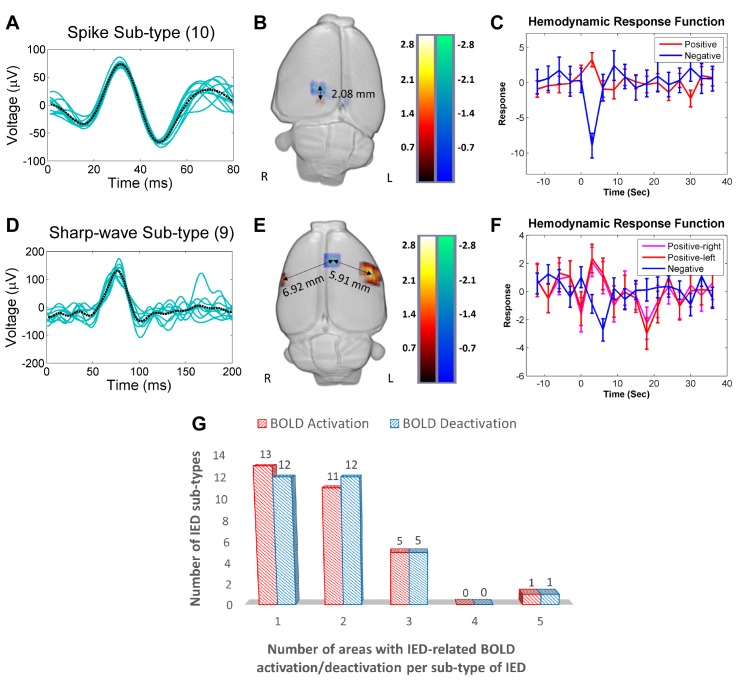
IED-evoked BOLD activations and deactivations.(A) A representative collection of a particular spike sub-type (10 events, Rat 6). The black dashed line represents the average of all events. (B) 3-D display of brain regions with either positive (red) or negative (blue) BOLD responses evoked by the spike sub-type shown in (A). In this case, the distance between the BOLD responses is 2.08 mm. (C) Hemodynamic response functions (HRFs) extracted from the regions with a positive and a negative BOLD responses shown in (B). (D) A representative collection of a particular sharp-wave sub-type (9 events, Rat 1). The black dashed line represents the average of all events. (E) 3-D display of the regions showing either a positive (red) or a negative BOLD response evoked by the spike sub-type shown in (D). The distances between the region with a negative BOLD response and those two with a positive BOLD response are 6.92 mm (right hemisphere) and 5.91 mm (left hemisphere). (F) HRFs extracted from the regions with either a positive or a negative BOLD response shown in (E). (G) Numbers of the positive (red) and the negative (blue) BOLD regions versus the IED sub-type. For example, among all the studied rats, there are thirteen sub-types of IEDs that induce BOLD activation in a single brain area. R = right; L = left; BOLD = blood-oxygen-level dependent; IED = interictal epileptiform discharge.